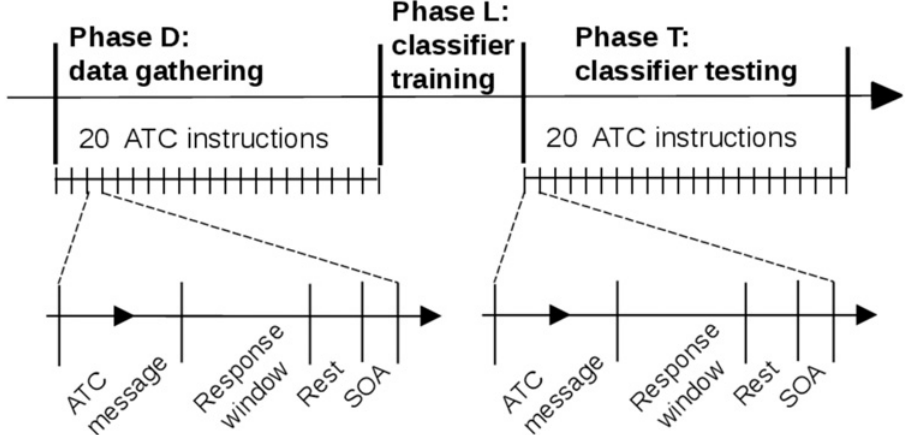
Fig 5. The experiment was split into three successive phases. Data gathering ( phase D ) and classifier testing ( phase T ) consisted of 20 ATC instructions each. The pilot ’ s classifier was trained between these two phases ( phase L ). The time scale of the figure is